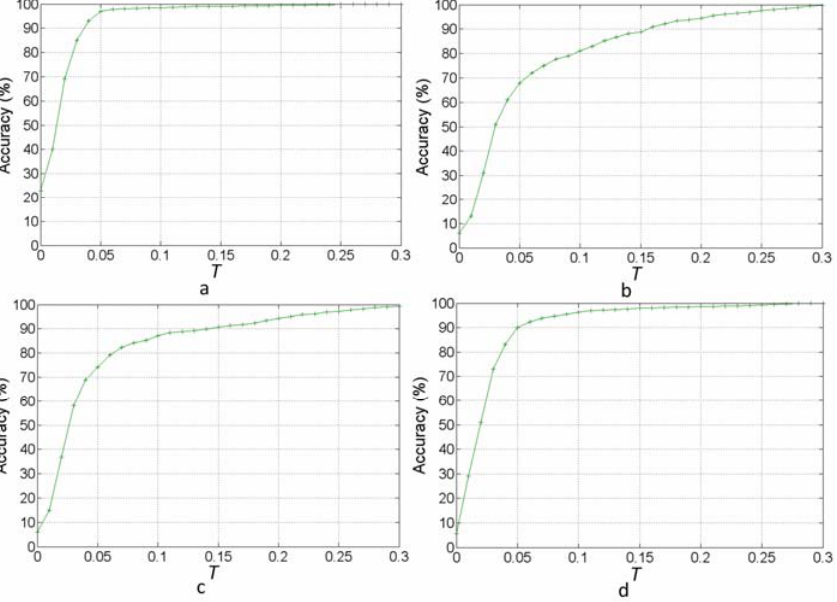
Figure 16: The distribution functions of relative error against accuracy of our proposed method with respect to true iris center. (a) Center, (b) Left, (c) Right, (d) Upper.